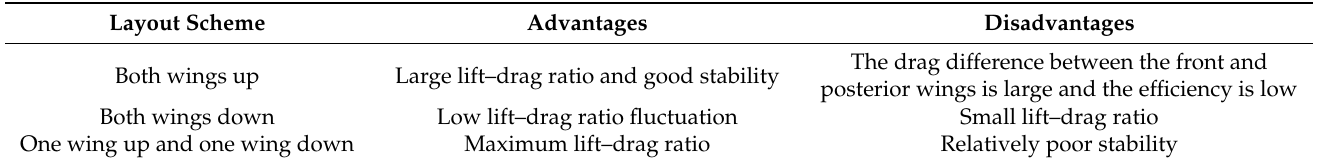
Table 1. Advantages and disadvantages of different layout schemes.